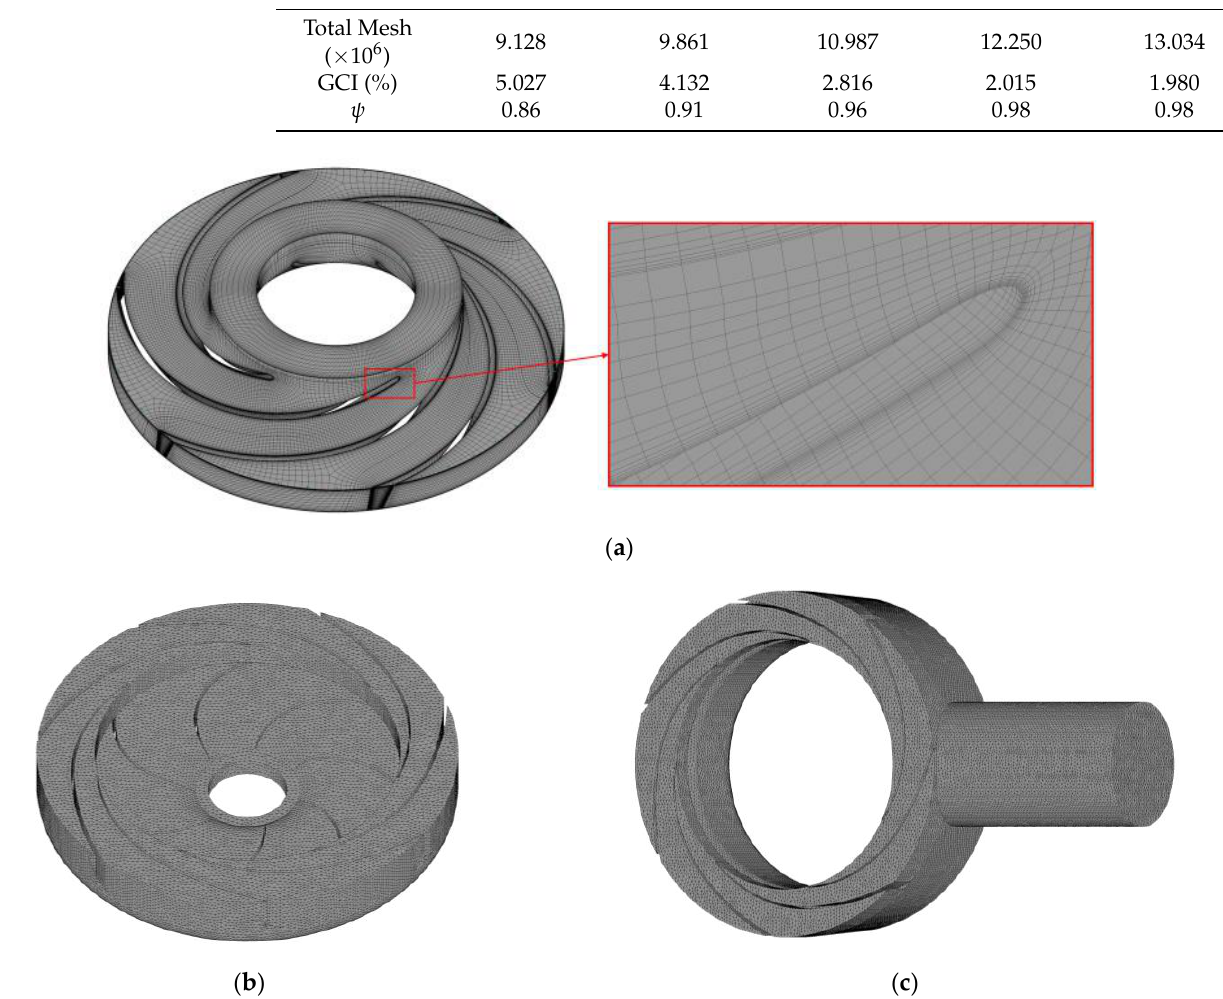
Figure 4. Mesh of the computational domain. ( a ) Impeller; ( b ) guide vane; ( c ) stage three guide vane with volute.